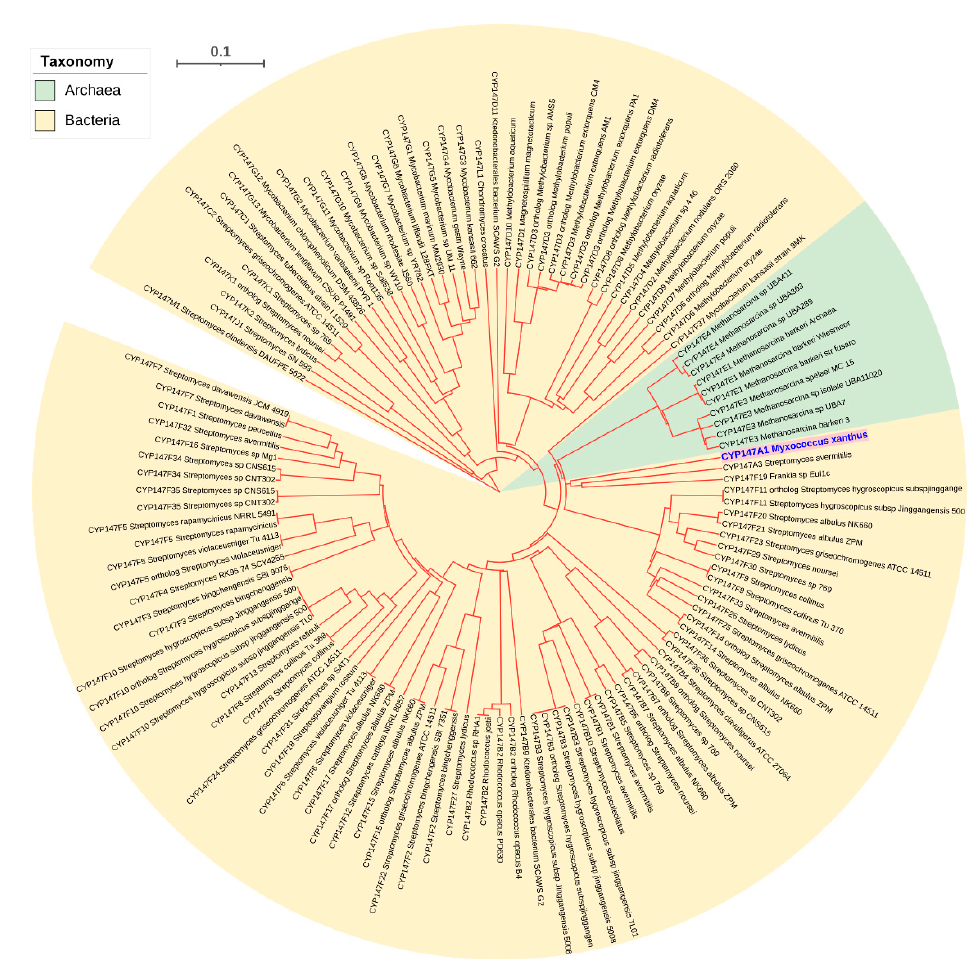
Figure 5. Phylogenetic analysis of the CYP147 P450 family members from archaea and bacteria. Differ- ent colors highlighted CYP147 members from Methanosarcina and CYP147A1 from Myxococcus xanthus . The tree branch length is indicated as the scale bar in the upper left corner. CYP147 members used in constructing the phylogenetic tree are presented in Table S7. The protein sequences were aligned by MAFFT v6.864 [36] and the tree was inferred by the Trex web server [37].